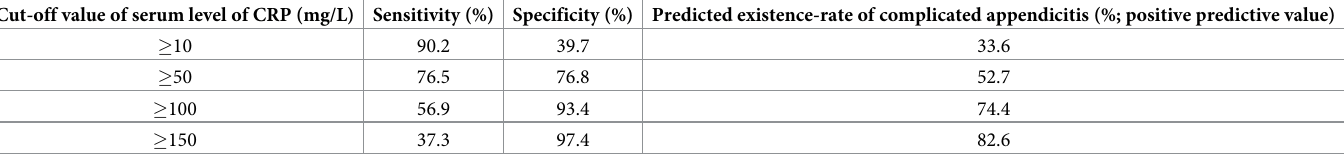
Table 4. Sensitivities, specificities, and predicted existence rates for cut-off values of serum level of C-reactive protein